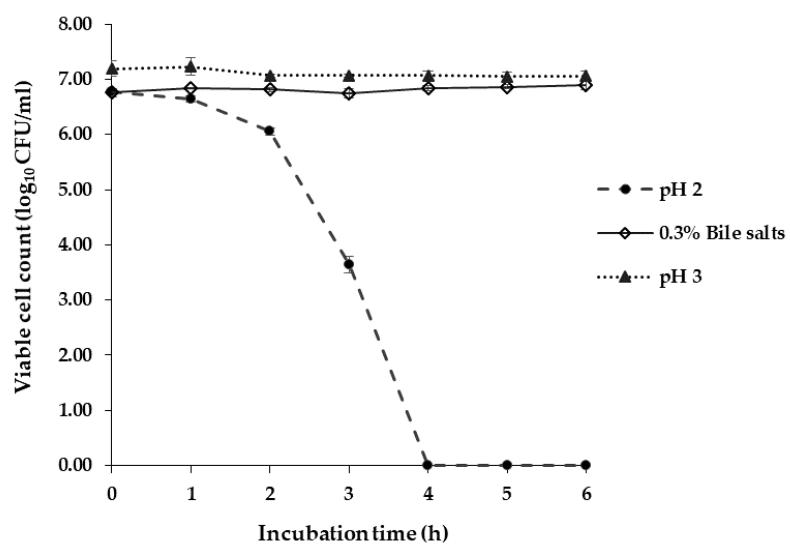
Figure 4. Viable cell count (log 10 colony-forming units (CFU)/mL) of L. brevis F064A against acidic condition (pH 2.0 and pH 3.0) and 0.3% ( w/v ) of bile salts. The experiments were triplicate. The results represented as mean ± S.D. ( n = 3).